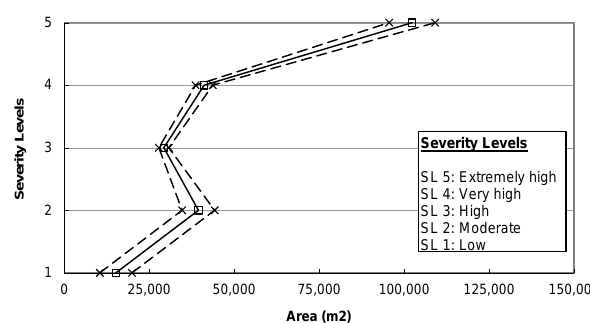
low (1) and high (3). For flow case 300 m 3 s − 1 low,